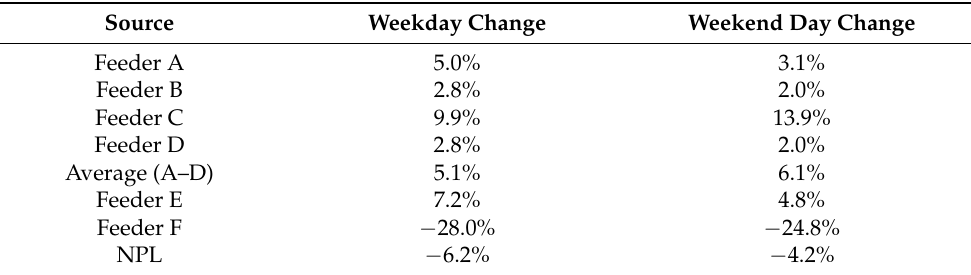
Table 4. Energy use difference for mid-March through April comparing 2020 against a counterfactual baseline of 2018–2019. The all-day average for Feeders A–D was